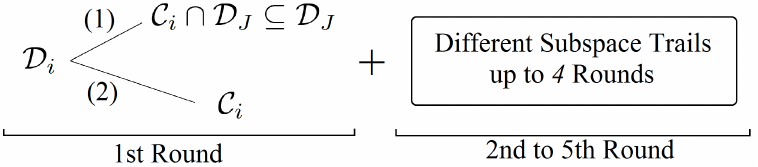
Figure 8: Strategy of the attacks on AES with a secret S-Box . Starting with a subset of a coset of D i which depends on the guessed values of the secret key, it is mapped after one round into a subset of a coset of D J if the guessed values is correct - case (1), or into a subset of a coset of C i if the guessed values is wrong - case (2). As a consequence, the subspace trails up to the 5- th round are different for the two cases, and this allows to set up various key-recovery